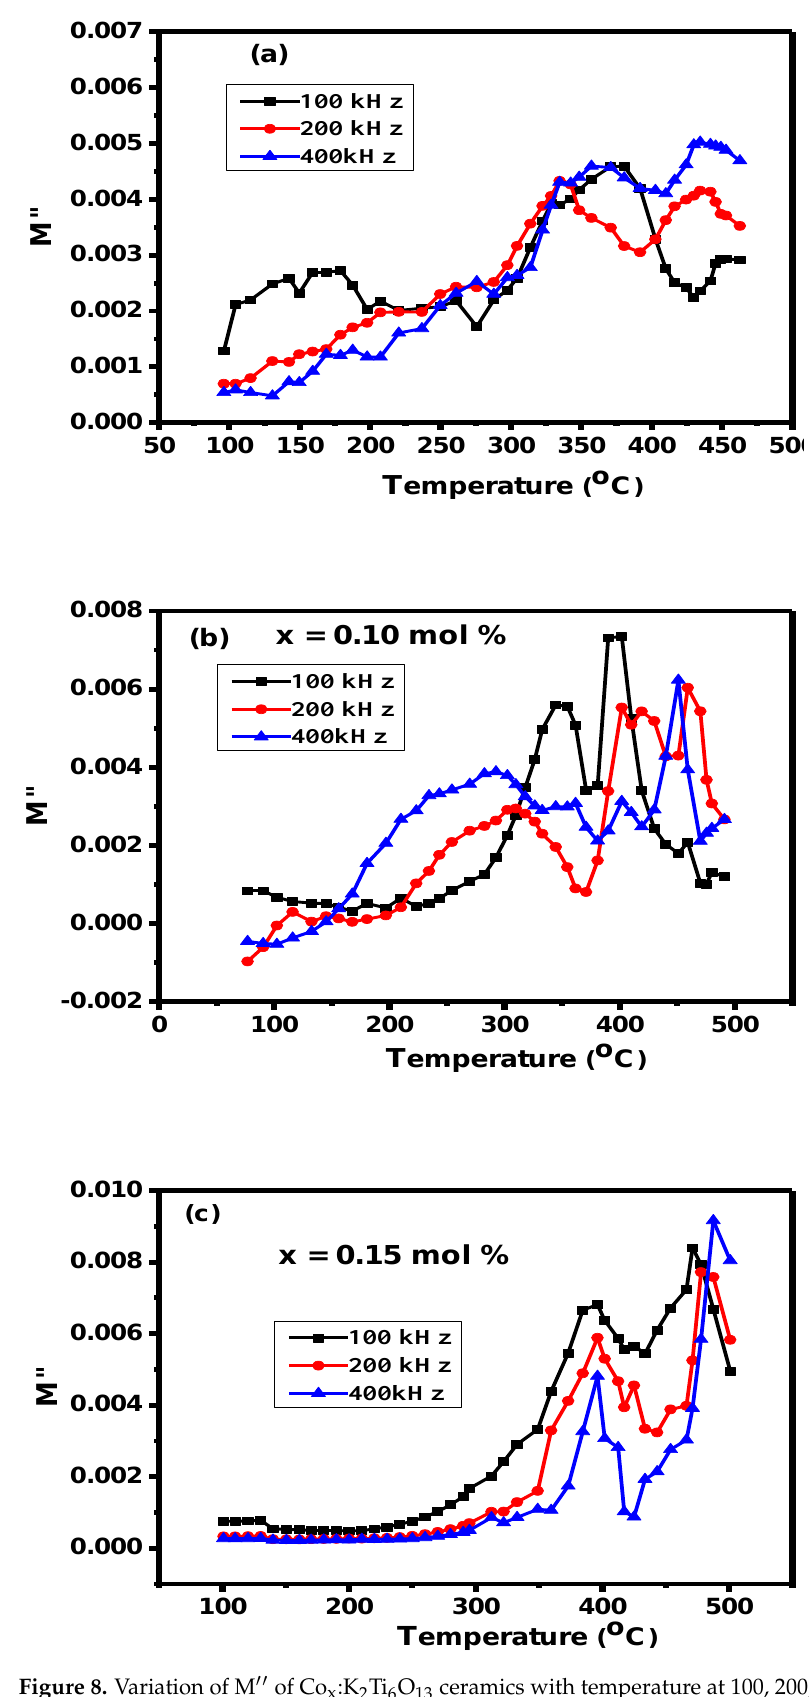
Figure 8. Variation of M′′ of Co x :K 2 Ti 6 O 13 ceramics with temperature at 100, 200, and 400 kHz ; ( a ) is for Co 0.05 :K 2 Ti 6 O 13 , ( b ) is for Co 0.10 :K 2 Ti 6 O 13 and ( c ) is for Co 0.15 :K 2 Ti 6 O 13 .